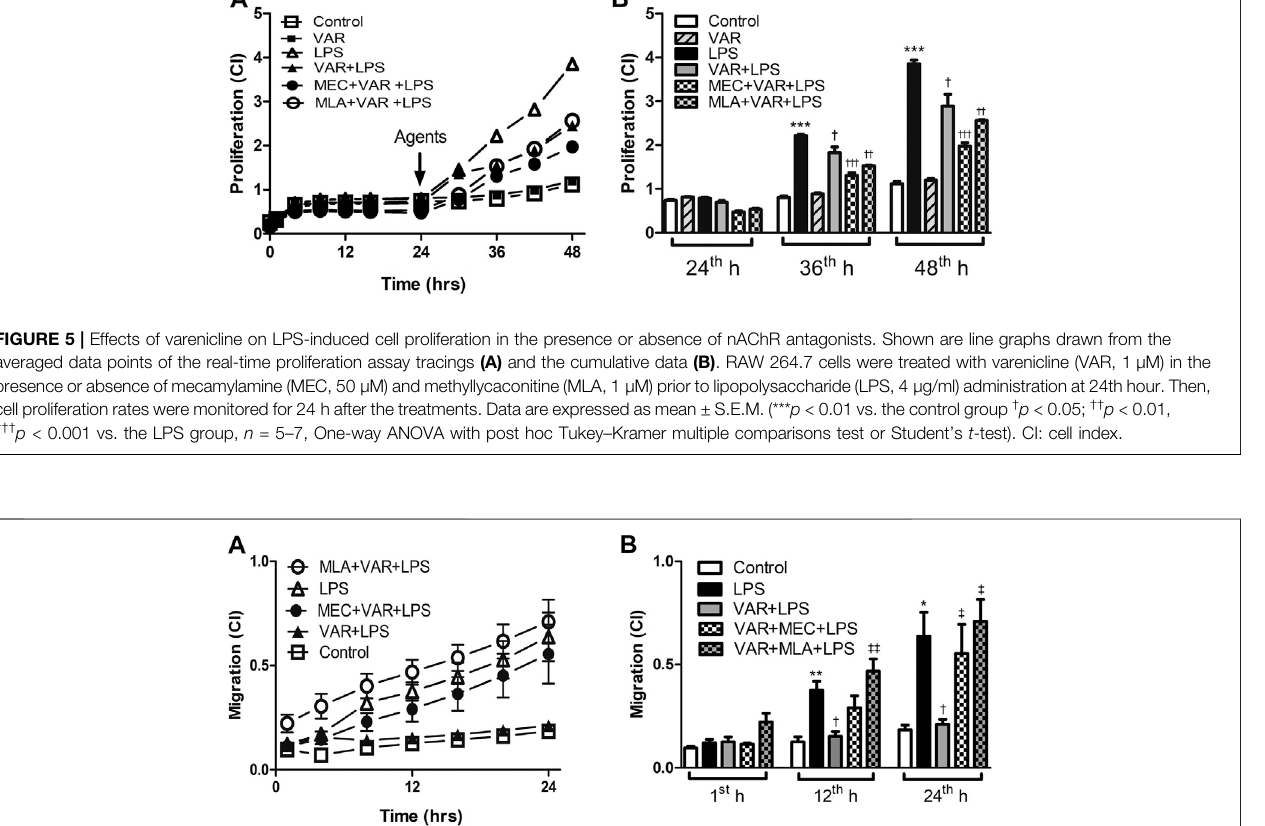
Frontiers in Molecular Biosciences |